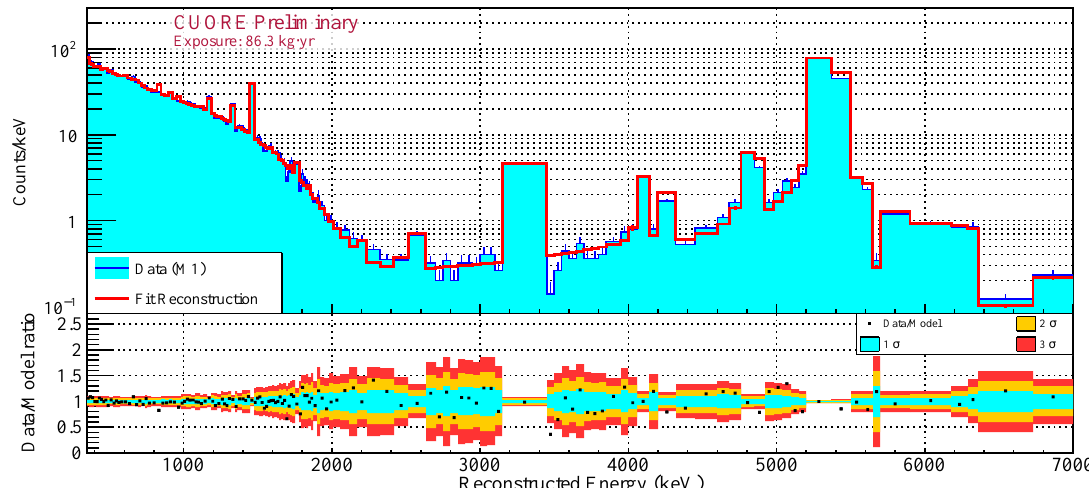
Figure 4. Top : M1L0 spectrum (blue) and the fit to the spectrum, built out of different simulated background components (red). The variable binning has been chosen to contain peaks into a single bin to avoid dependence on details of the peak shape while having good resolution of the model in the continuum region. Bottom : ratio of the data and reconstructed model with 1 σ , 2 σ and 3 σ error bars. The continuum is well described while we have moderate disagreement in the heights of a few peaks. Picture from